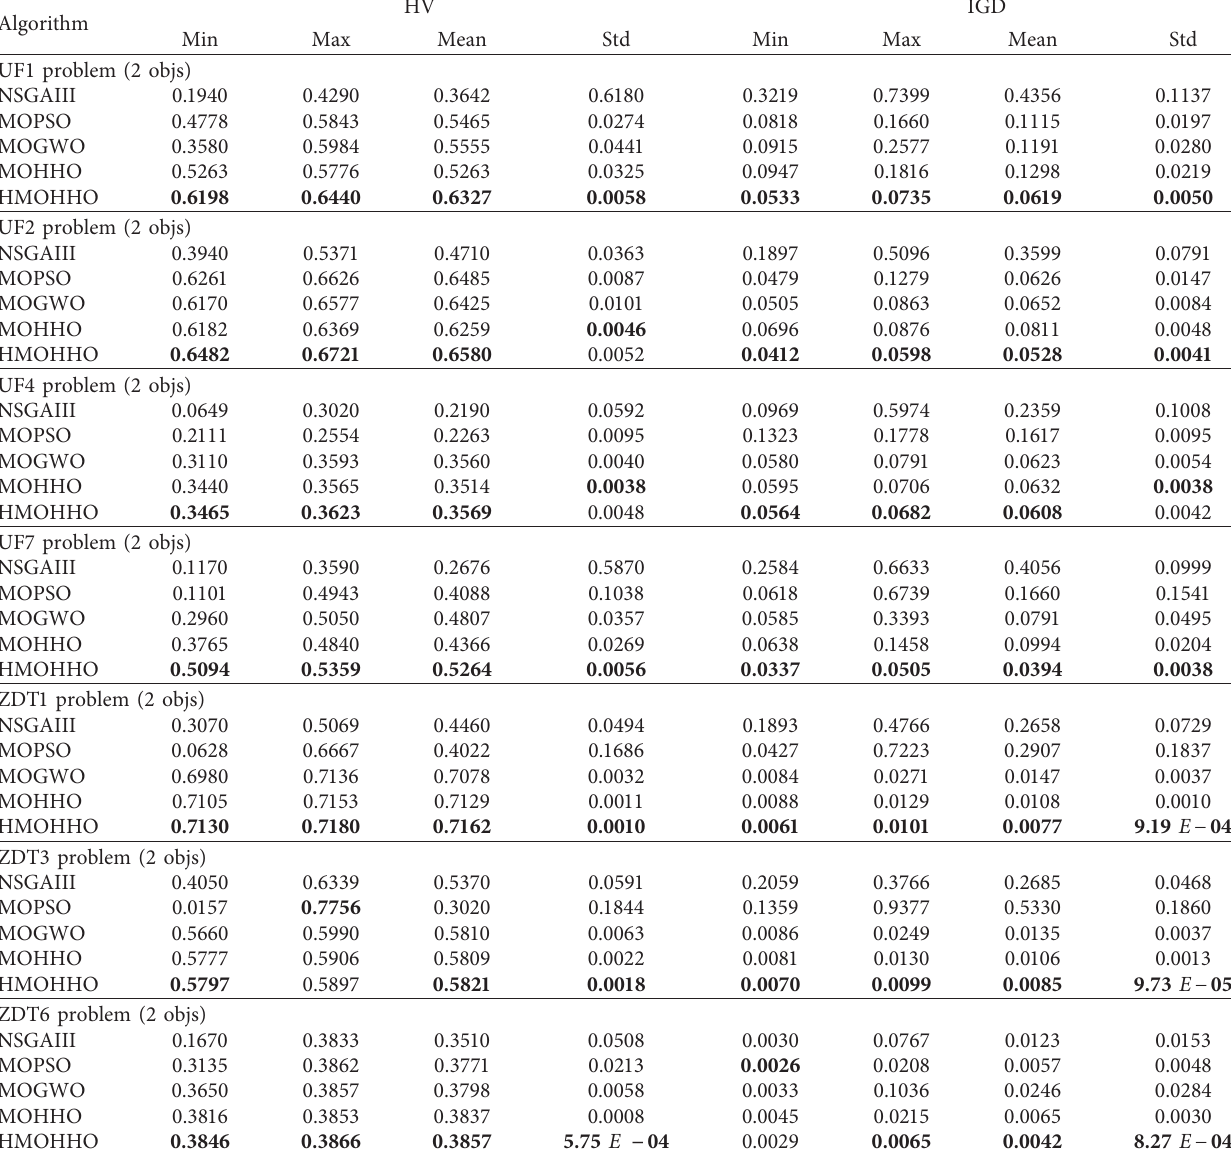
Table 3: HV and IGD statistical results of different